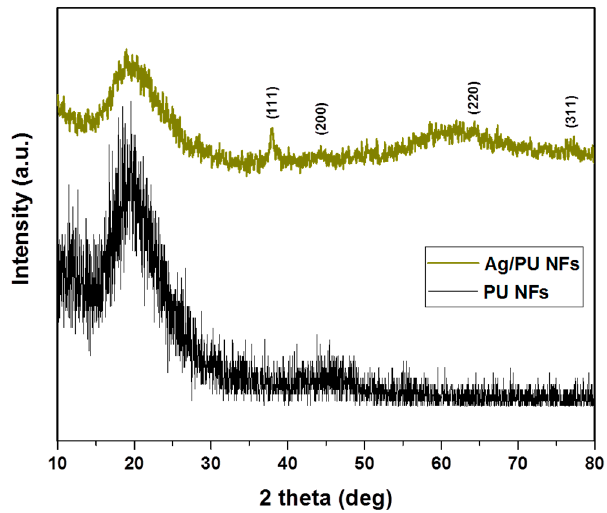
Figure 4. XRD spectra of the Ag / PU NF mat compared to the pristine PU NFs.